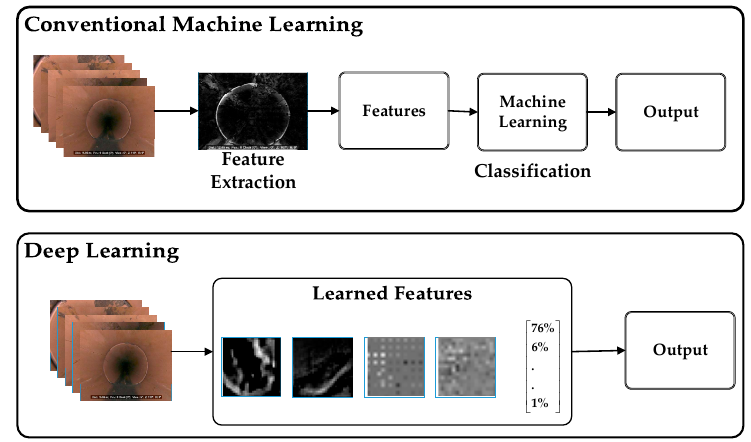
Figure 7. Machine learning approach and deep learning approach comparison.